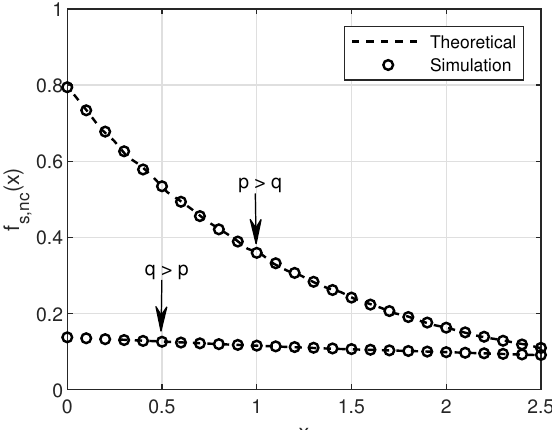
Figure 3. Theoretical and simulation plot of SNR in no-collision case with a) p = 10 dB and q = 1 dB (i.e., p > q ) and b) q = 10 dB and p = 1 dB (i.e., q > p ).